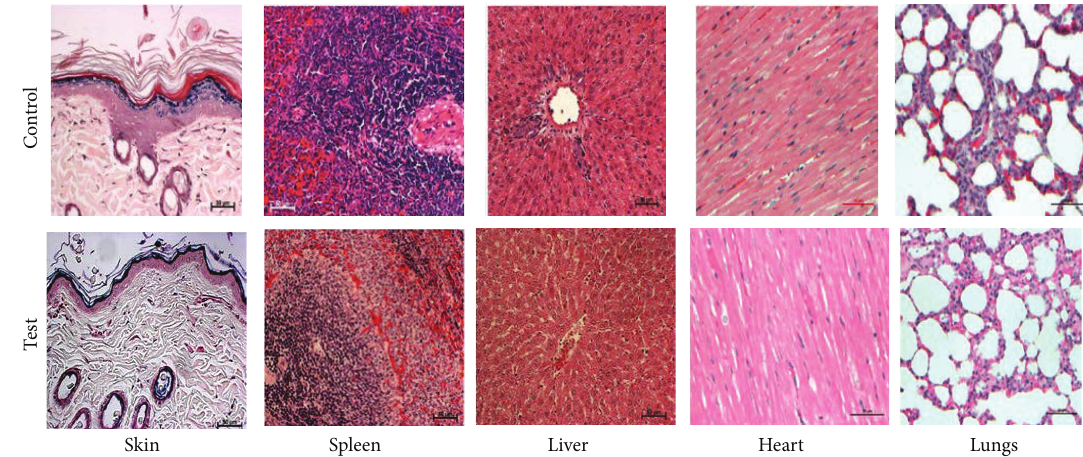
Figure 2: Photomicrographs of histopathology of skin, spleen, liver, heart, and lungs (test and control).